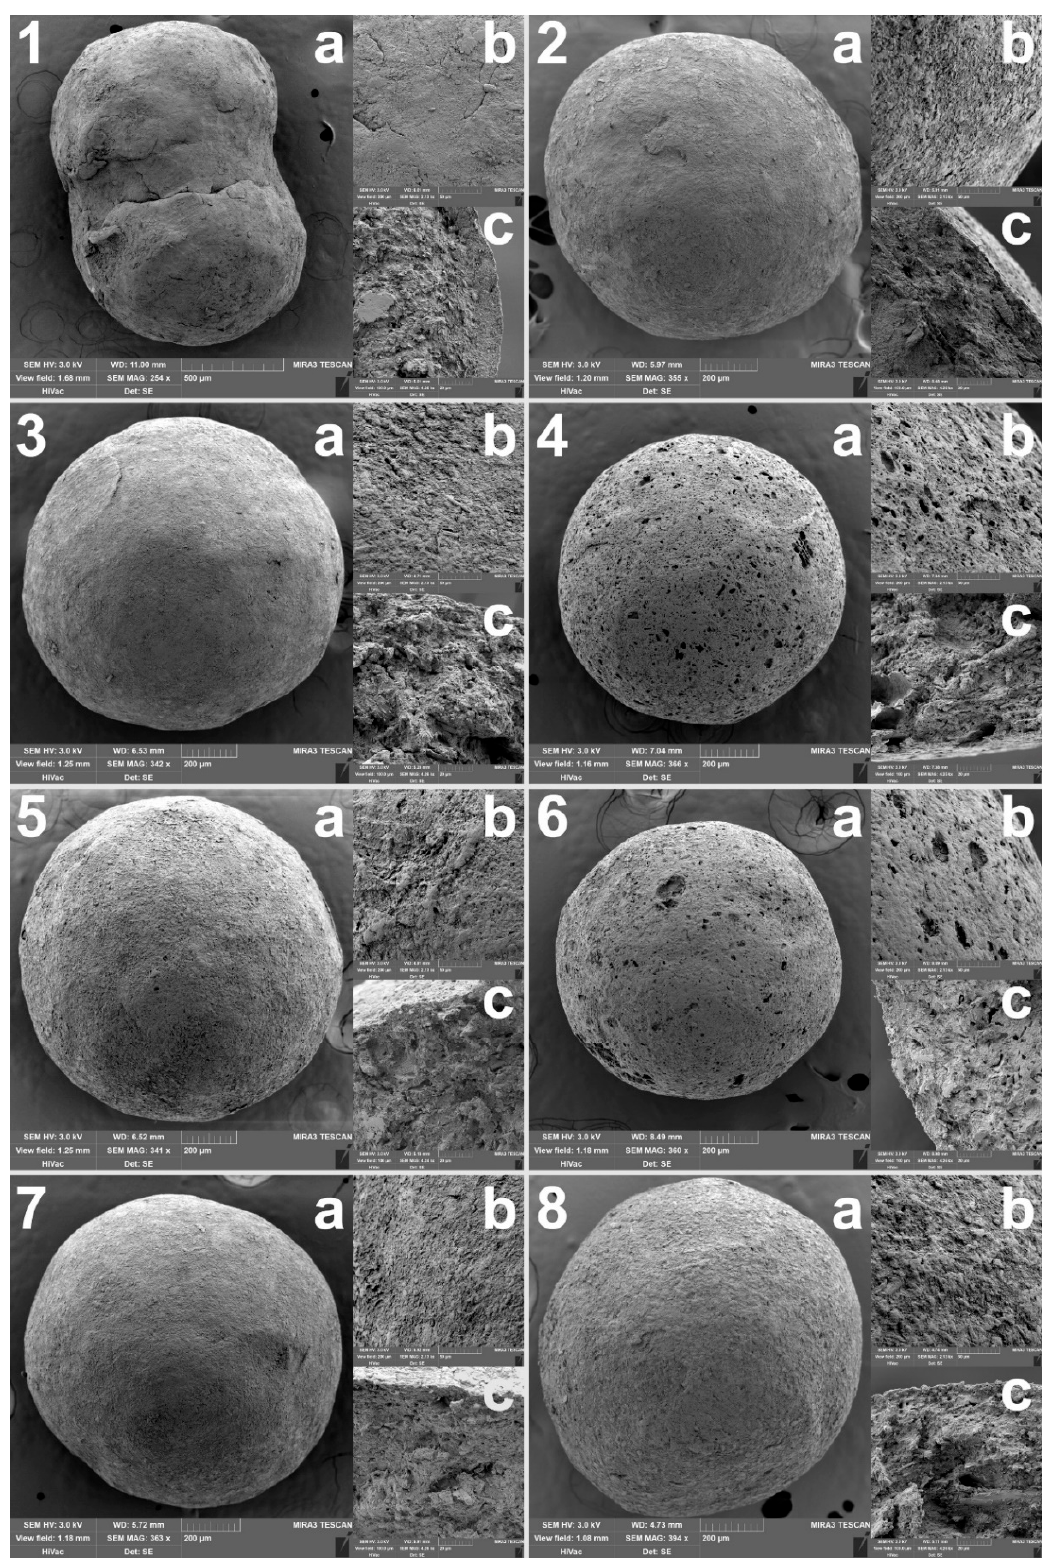
Figure 2. SEM images of selected samples, where 1 is a sample without Neusilin ® US2 (N0), 2 is a sample with 25% (w/w) of Neusilin ® US2 (N). The remaining samples had a specific surface area modified by the addition of volatile substances, which sublimed during drying: samples 3 (M7.5) and 4 (M20.0) originally contained 7.5% and 20.0% (w/w) menthol, similarly samples 5 (C7.5) and 6 (C20.0) contained camphor and samples 7 (AB7.5) and 8 (AB20.0) contained ammonium bicarbonate. In addition, ( a – c ) denote the whole pellet, the surface detail and the cross ‐ section detail, respectively.